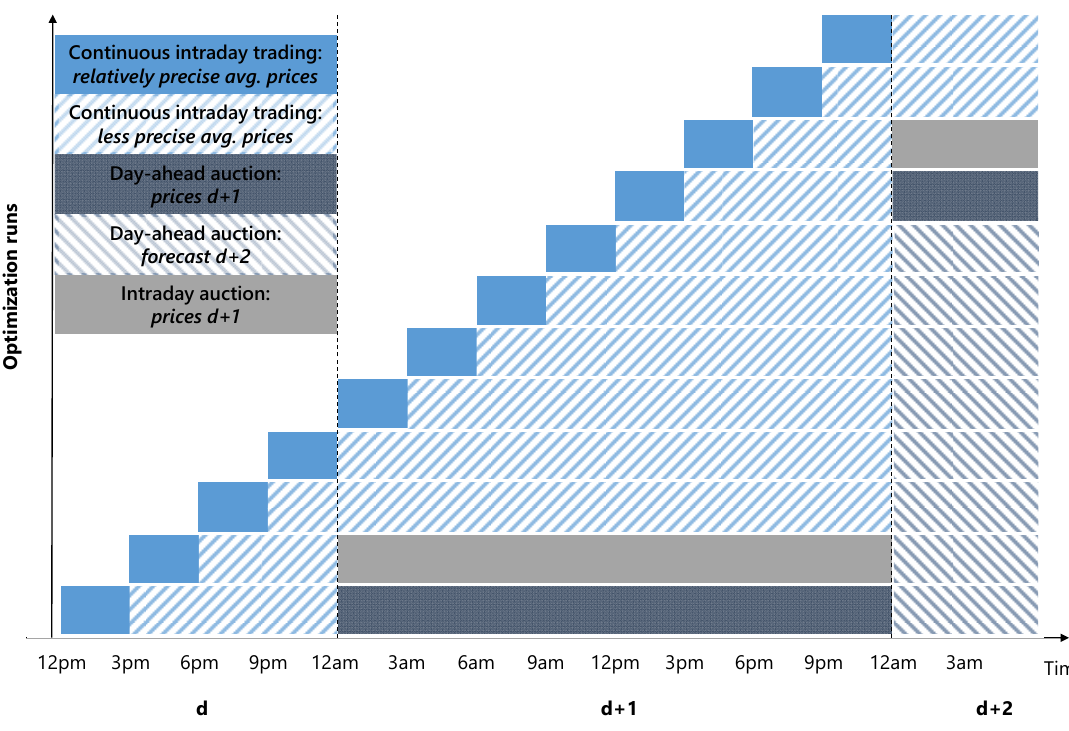
Figure 2. Schematic representation of the optimization steps with limited foresight of market prices.